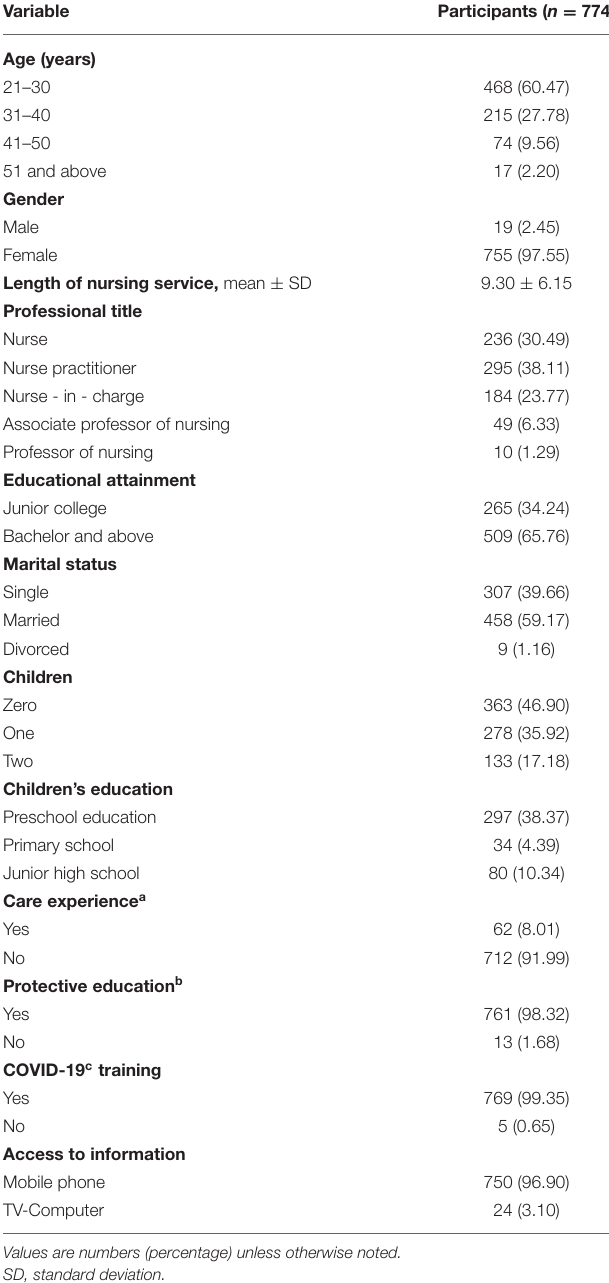
TABLE 1 | Demographic characteristics of the survey